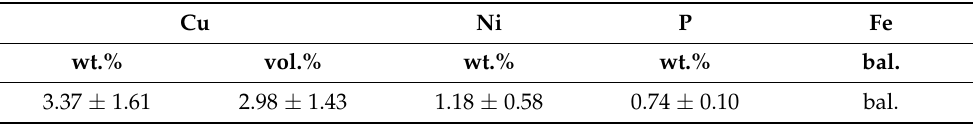
Table 8. Chemical composition of sintered samples assessed by